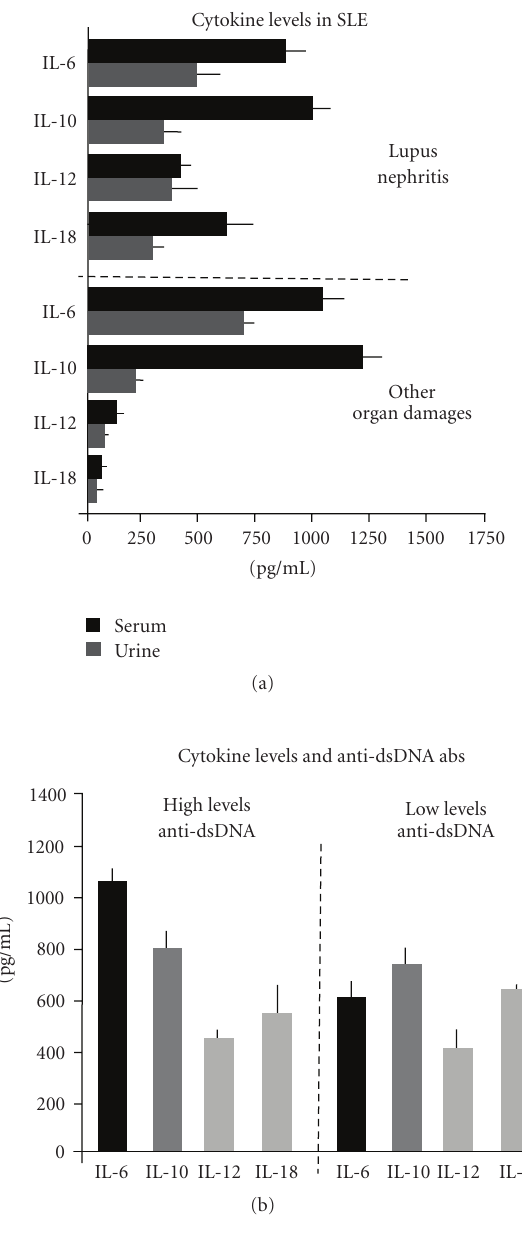
Figure 2: Th1/Th2 cytokine profile in SLE. (a) Patients with LN ( n = 69) produced large amounts of both IL-12 and IL-18, both in sera (black column) and urine (gray column). By contrast, those with di ff erent organ damages ( n = 181) excluding LN, showed the highest production of IL-6 and IL-10. (b) IL-6 was overproduced in patients with high levels of anti-dsDNA antibodies independently from the presence of LN. Other cytokines were poorly associated with nephritogenic antibody